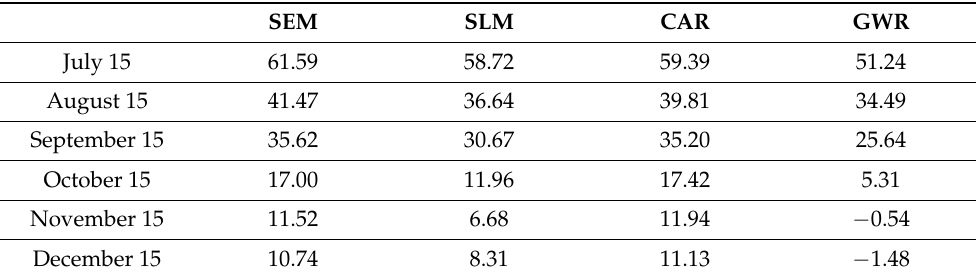
Table 6. Summary of models’ AIC values over